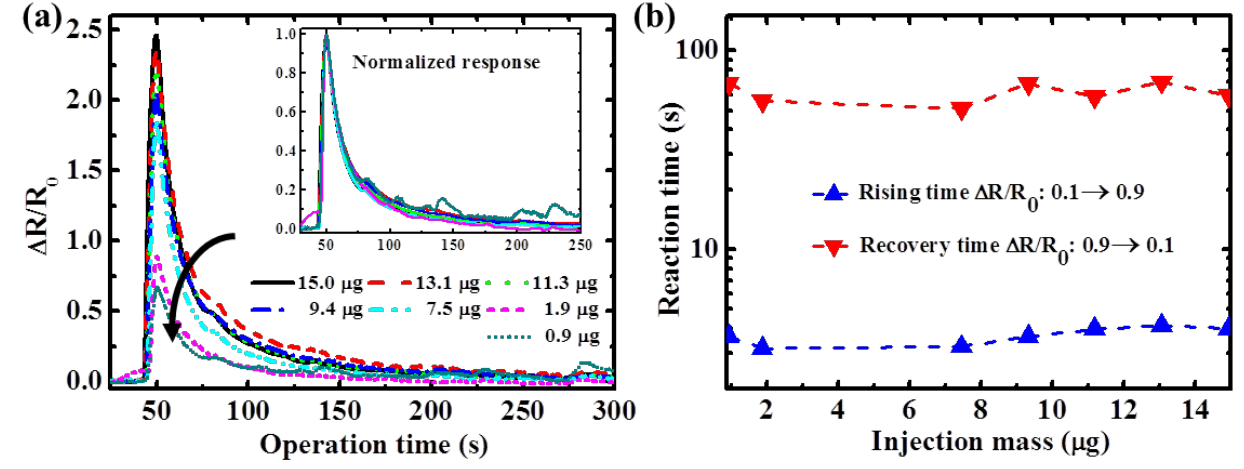
Figure 6. ( a ) Transient sensing responses and ( b ) reaction times of the TiO sensors at 300 °C with various ethanol injection mass quantities.